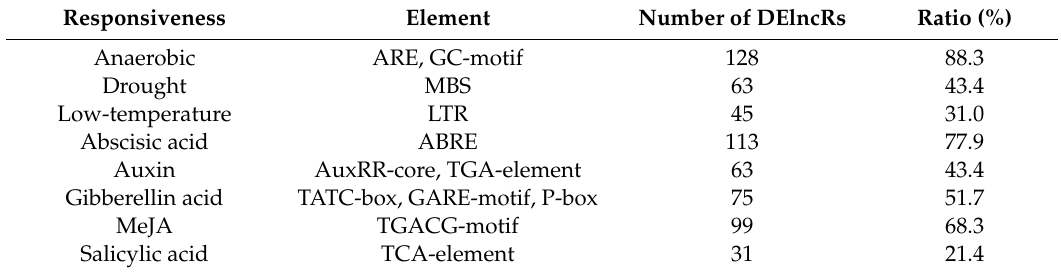
Table 1. The stress- and hormone-responsive elements in the 1.5 kb promoter region of the high-confidence hypoxia response of long non-coding